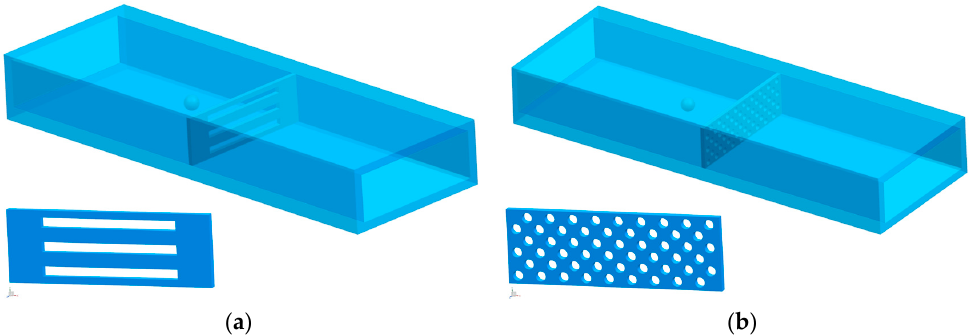
Figure 2. The periodic boundary condition is set at the lateral side of the fluid body: ( a ) filtering film with 100 μ m × 7 μ m slit-shaped pores; ( b ) filtering film with ϕ 7 μ m circular pores. The section of the fluid body is 150 μ m × 41 μ m, and the total length is 500 μ m.